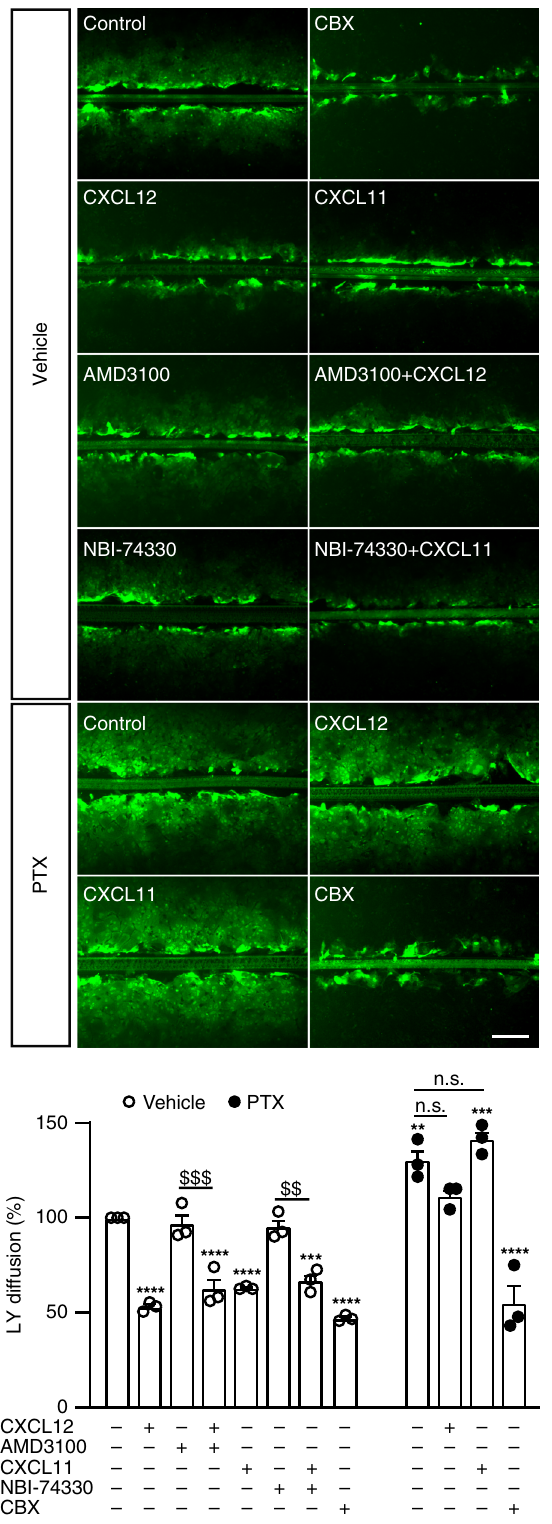
CXCL12, but not mouse ACKR3, caused a decrease in the BRET signal between venus-G γ 2 and G α i3 -RLuc in HEK293T cells (Supplementary Fig. 3d), suggesting that the ability of ACKR3 to activate G α i/o proteins in mouse astrocyte cultures does not re fl ect different coupling properties of mouse and human ACKR3.